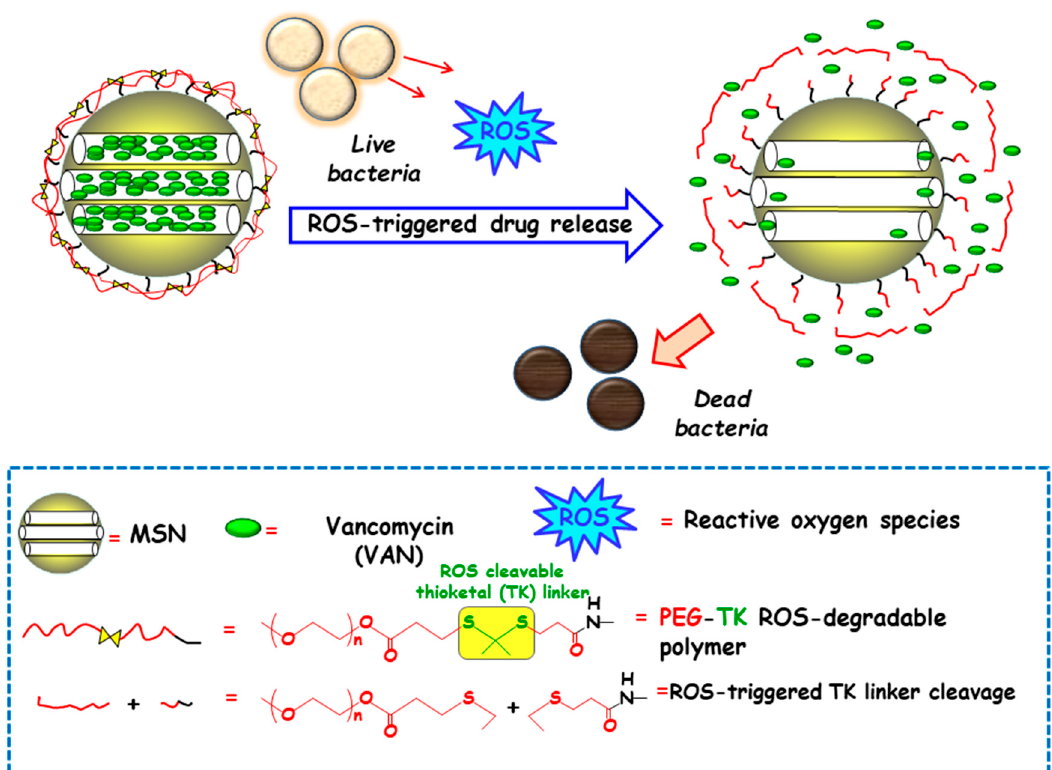
Figure 8. Schematic depiction of the operating mechanism of reactive oxygen species (ROS)-responsive antimicrobial nanosystems consisting of MSN loaded with vancomycin (VAN) and capped with a ROS-degradable thioketal grafted methoxy poly(ethylene glycol) (mPEG-TK) gate-like shell. Adapted from ref. [91]. The presence of ROS in the bacteria microenvironment triggers the cleavage of TK linker and the polymeric cap degradation, which produces pore uncapping, VAN release and bacteria killing.